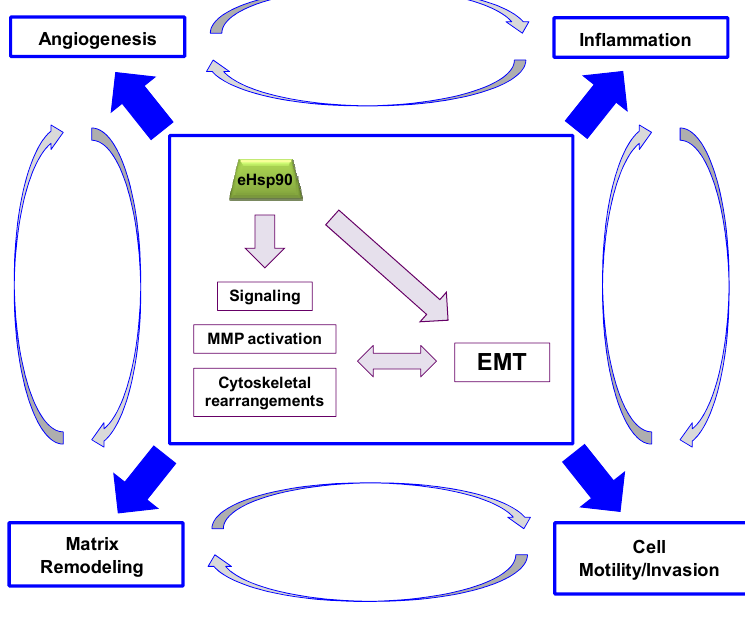
Figure 3. Conserved functions of eHsp90 in wound repair and cancer. Central box depicts key molecular aspects of eHsp90 action highlighted in this review. These molecular events have the potential to elicit or support EMT activation, and EMT activation is reciprocally associated with heightened activation of these functions. Some of the key functional outputs of eHsp90 function are depicted in each corner of the box: Angiogenesis, Inflammation, Matrix Remodeling and Cell Motility and Invasion. As indicated, each of these functions may crosstalk and integrate with any of the other outputs to contribute to the highly complex tumor